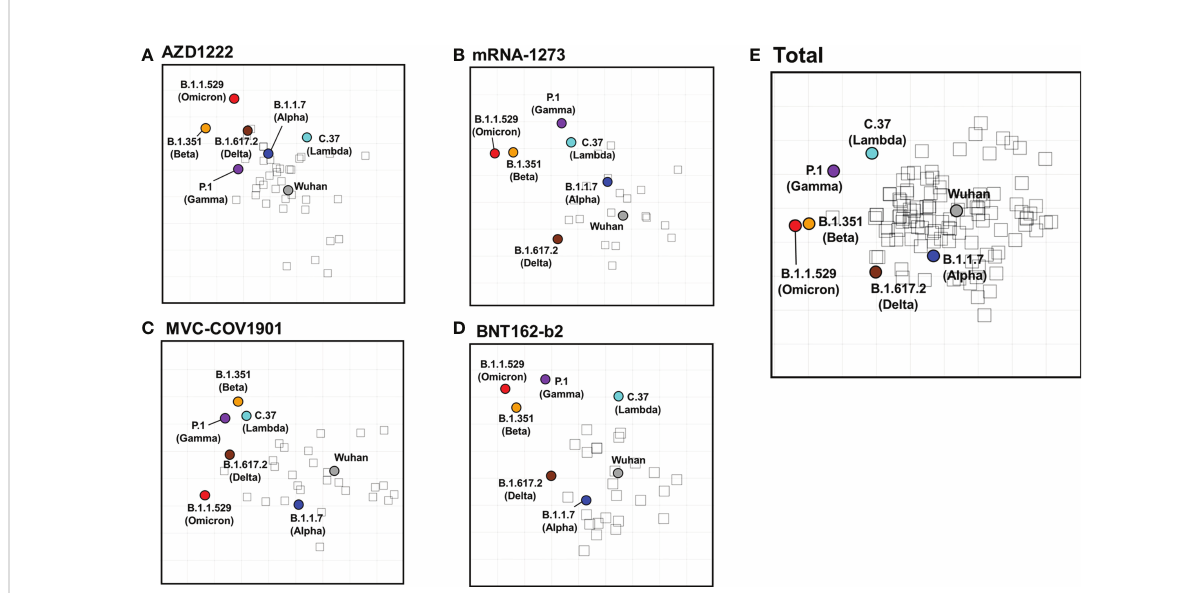
FIGURE 5 SARS-CoV-2 antigenic cartography generated from neutralizing antibodies response of different vaccine brands. Antigenic maps of SARS-CoV-2 VOCs were generated using neutralizing antibody titers from (A) AZD1222, (B) mRNA-1273, (C) MVC-COV1901, (D) BNT162-b2, and (E) total vaccinees ’ sera. SARS-CoV-2 VOCs are shown as colored circles and sera are indicated as hollow squares. Both the x and y-axes of the map are antigenic distance, and each grid square (1 antigenic unit) represents a 2-fold change in neutralization